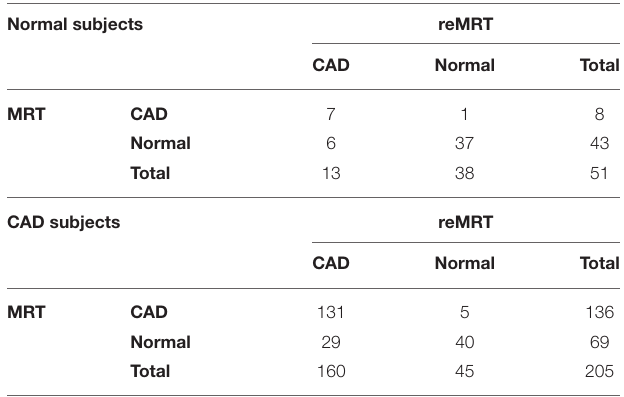
TABLE 6 | Multivariable logistic regression estimated model. Variable